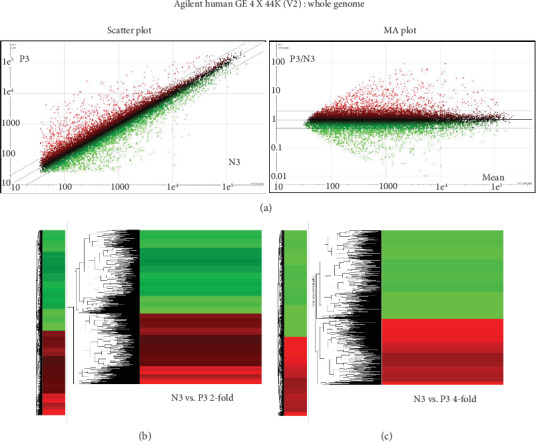
Microarray analysis of hUCB-MSCs from the normal and preeclampsia groups. (a) The scatter plot and MA plot show the DEGs between N3 and P3 cells. In the scatter plot, the median line indicates no difference in signal intensity between the two groups. The upper gray line indicates a twofold higher signal intensity, and the lower gray line indicates a twofold lower signal intensity for hUCB-MSCs from the preeclampsia group as compared to the normal group. In the MA plot, the median line represents N signal/P signal = 1. The upper gray line represents N signal/P signal = 2, and the lower gray line represents N signal/P signal = 0.5. N3: hUCB-MSCs at passage 3, normal pregnancy; P3: hUCB-MSCs at passage 3, preeclampsia. (b, c) Hierarchical cluster analysis of differentially expressed genes (DEGs) between N3 and P3 cells. Red represents upregulated gene clusters, and green represents downregulated gene clusters. The panels show genes up- or downregulated twofold (b) or fourfold (c) in P3 (versus N3) cells. N3: hUCB-MSCs at passage 3, normal pregnancy; P3: early hUCB-MSCs at passage 3, preeclampsia.